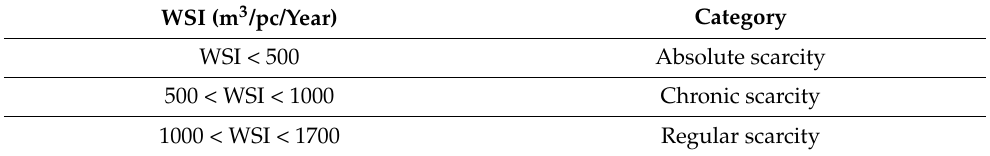
Table 1. Water scarcity-level classification in accordance with the Water Stress Indicator.